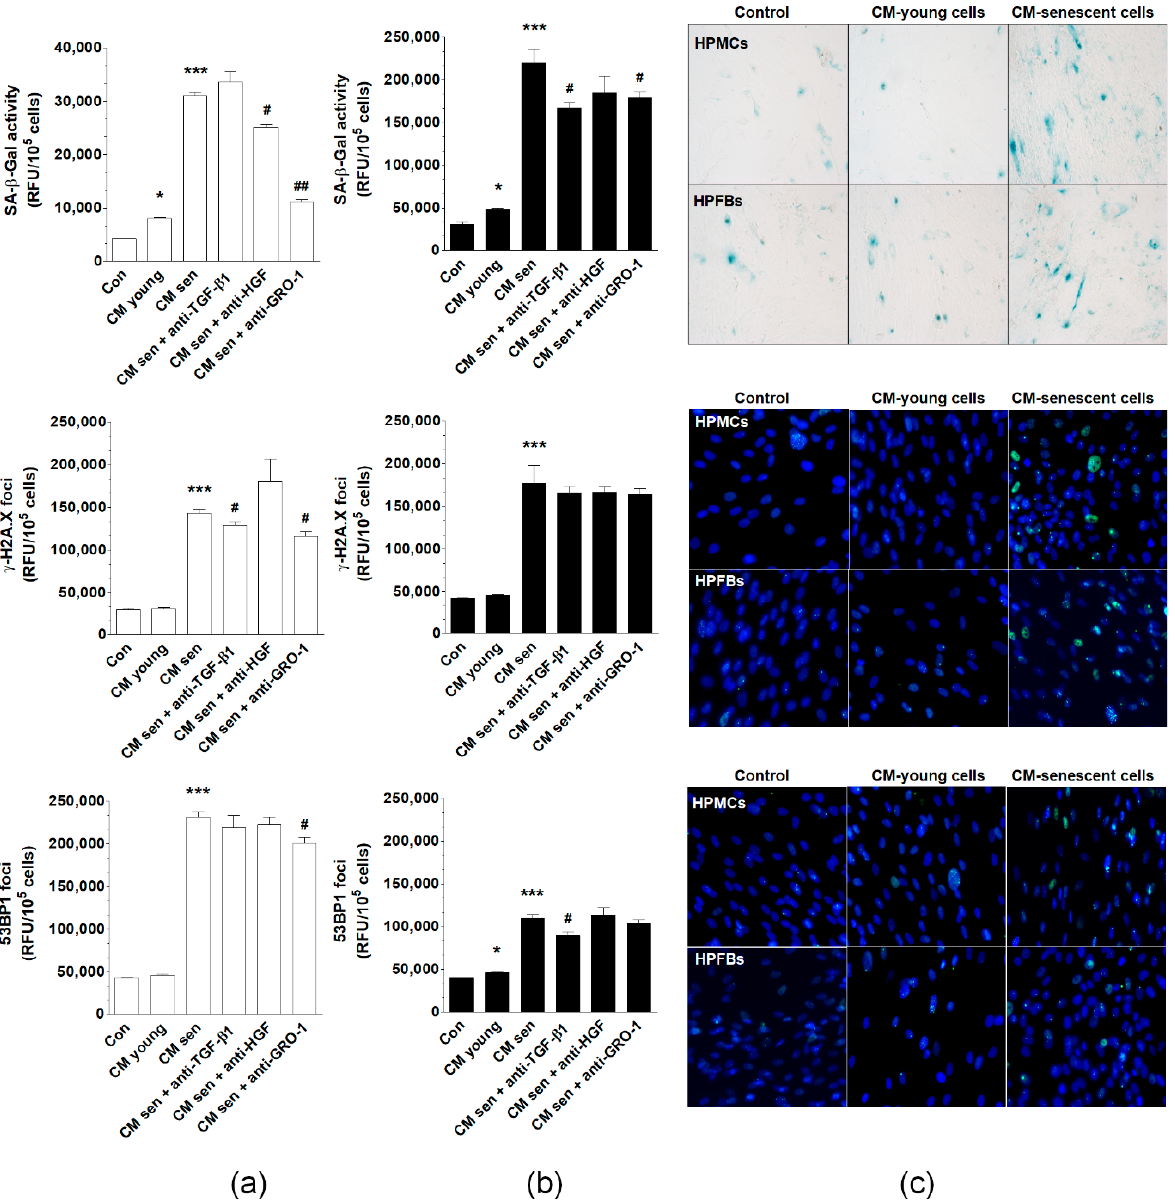
Figure 7. Effect of normal peritoneal mesothelial cells (HPMCs) and fibroblasts (HPFBs) on senescence induction in pEOCs. ( a ) Changes in SA- β -Gal, γ -H2A.X, and 53BP1 levels in pEOCs upon exposure to conditioned medium (CM) from young and senescent ( a ) HPMCs and ( b ) HPFBs. ( c ) Representative staining of SA- β -Gal, γ -H2A.X, and 53BP1 in pEOCs subjected to CM generated by HPMCs and HPFBs. Results are based on six independent experiments using pEOCs obtained from different patients. Results are expressed as mean ± SEM. * p < 0.05; *** p < 0.001 vs. Con.; # p < 0.05; ## p < 0.01. vs. CM from senescent cells. RFU—relative fluorescence units.